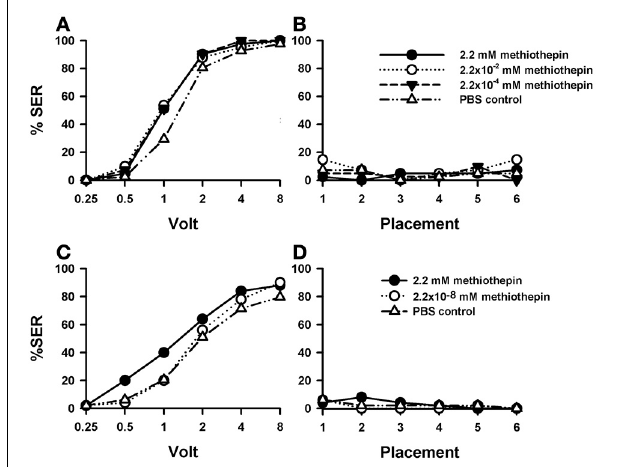
FIGURE 5 | Effects of 5-HT blocking on aversive responsiveness. (A,B) Three different groups of bees were injected with three different concentrations of the 5-HT antagonist methiothepin (2.2mM: n = 41; 2.2 × 10 − 2 mM: n = 41; 2.2 × 10 − 4 mM: n = 41). A fourth group was injected with PBS as a control ( n = 41). Sting responsiveness was measured in response to increasing voltages during shock trials (A) and during placement trials (B) . Taken globally, the three methiothepin concentrations assayed induced an almost significant increase of shock responsiveness when compared to the PBS control [ F ( 3 , 160 ) = 2 . 62, p = 0 . 052]. Yet, pairwise comparisons showed that each methiothepin concentration induced a significant increase of shock responsiveness with respect to PBS control ( p < 0 . 05 for all three comparisons). There were no differences between methiothepin-injected and PBS-injected bees in the placement trials. (C,D) A further replicate using a lower concentration of methiothepin. Two different groups were injected with two different concentrations of methiothepin, the highest one used in the previous replicate (2.2mM: n = 50) and a lower one (2.2 × 10 − 8 mM: n = 50). A third group was injected with PBS as a control ( n = 49). Sting responsiveness was measured in response to increasing voltages during shock trials (C) and during placement trials in which the bees were placed in the setup without stimulation (D) . The highest methiothepin concentration induced a significant increase of responsiveness during shock trials [ F ( 1 , 97 ) = 4 . 75, p = 0 . 032] while the lowest concentration did not [ F ( 1 , 97 ) = 0 . 48, p = 0 . 49]. No differences were detected in the placement